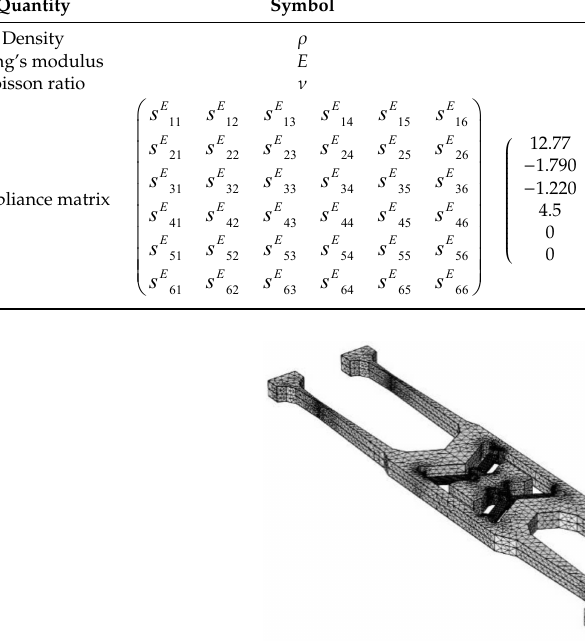
Figure 13. Meshing of the gyroscope model.